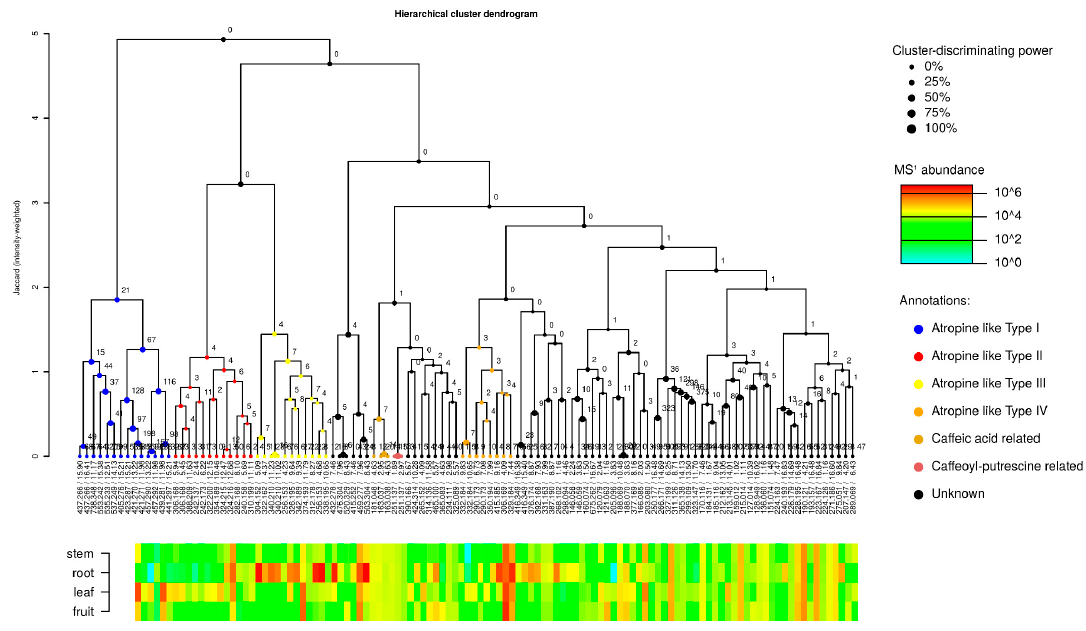
Figure 2. Prediction of compounds classes generated by MetFamily. Several MS 2 signals are annotated as tropane